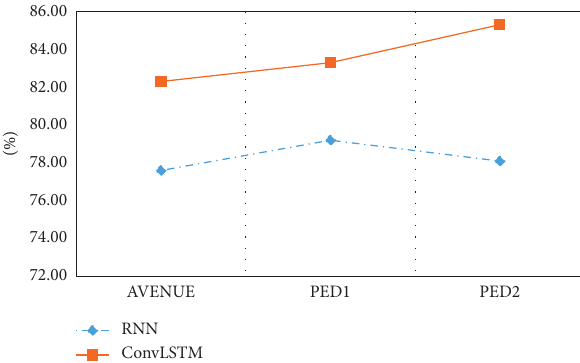
Figure 10: Comparison of experimental results of RNN and ConvLSTM.